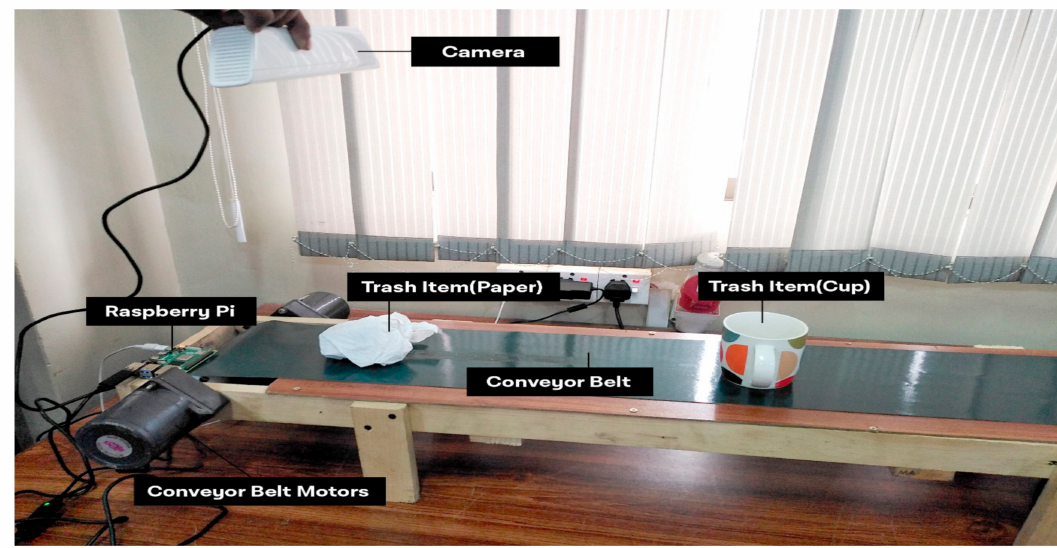
Figure 5. Experimental setup of waste